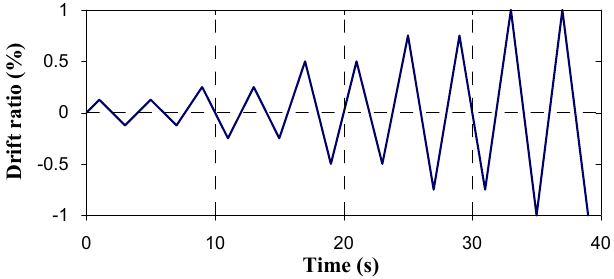
Figure 8. Loading history of the reversed cyclic loading test.